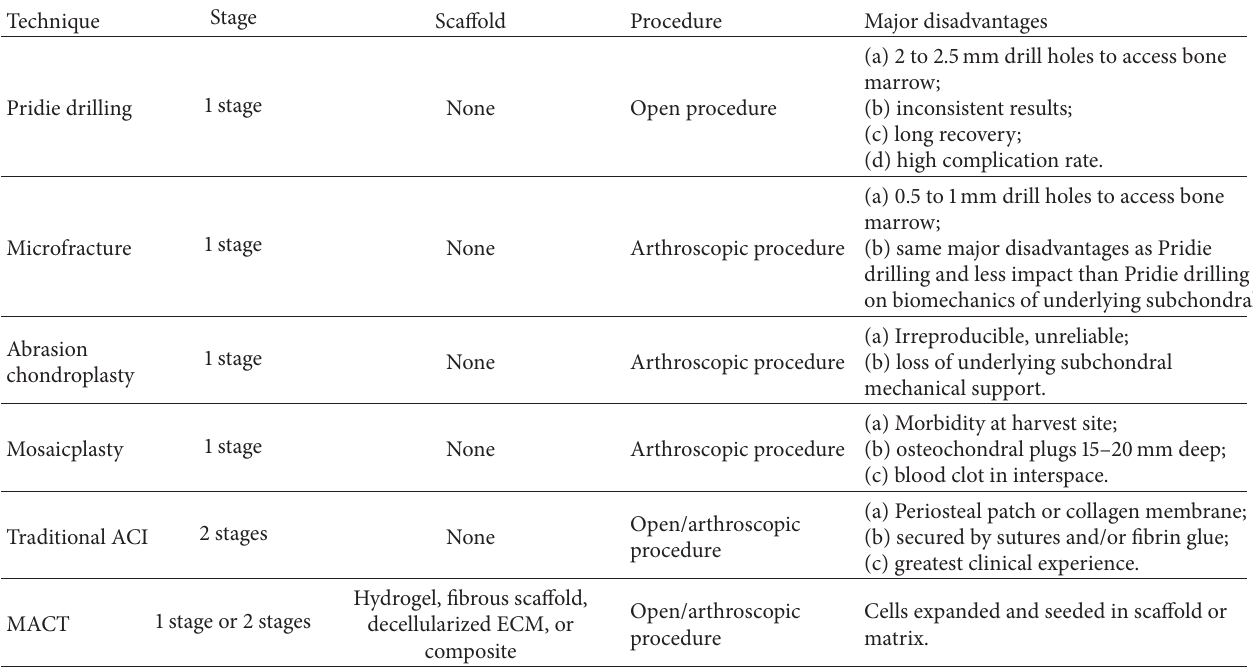
Table 1: Short description of major treatments for cartilage